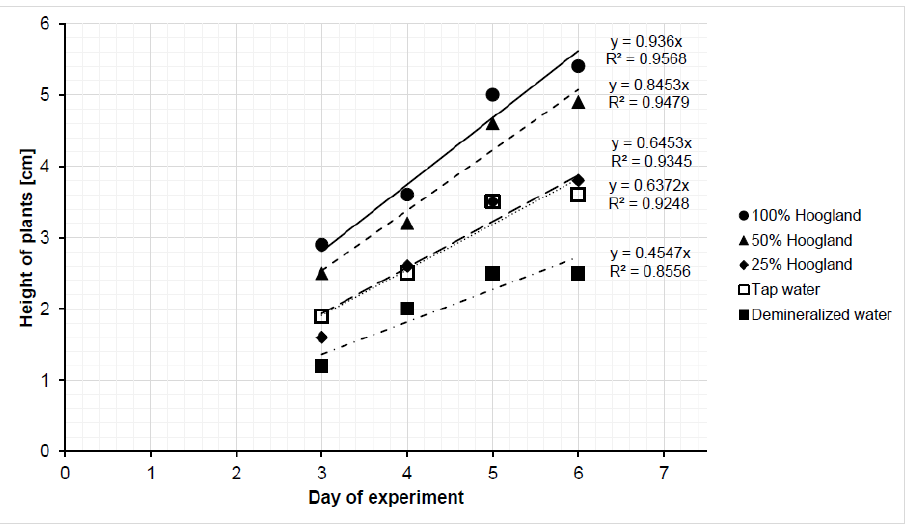
Figure 2. Average height growth of garden cress. A straight line through the origin connects the data points of the graph. R 2 is the square of the correlation coefficient.